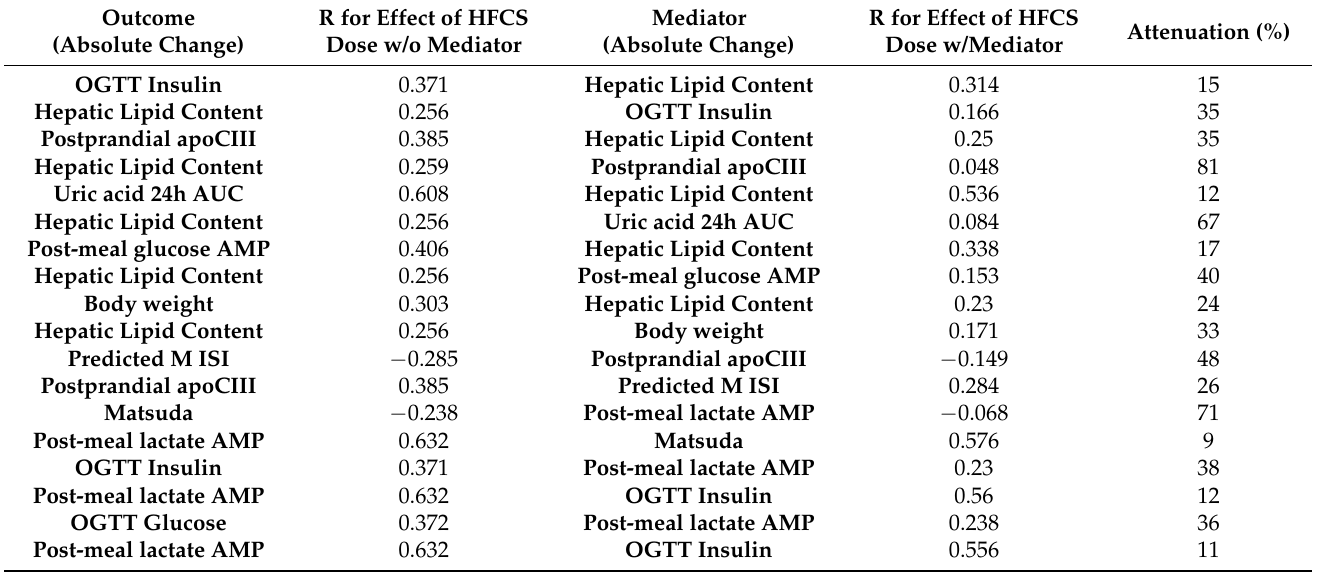
Table 4. Potential or partial mediator(s) of the effects of HFCS dose 1,2